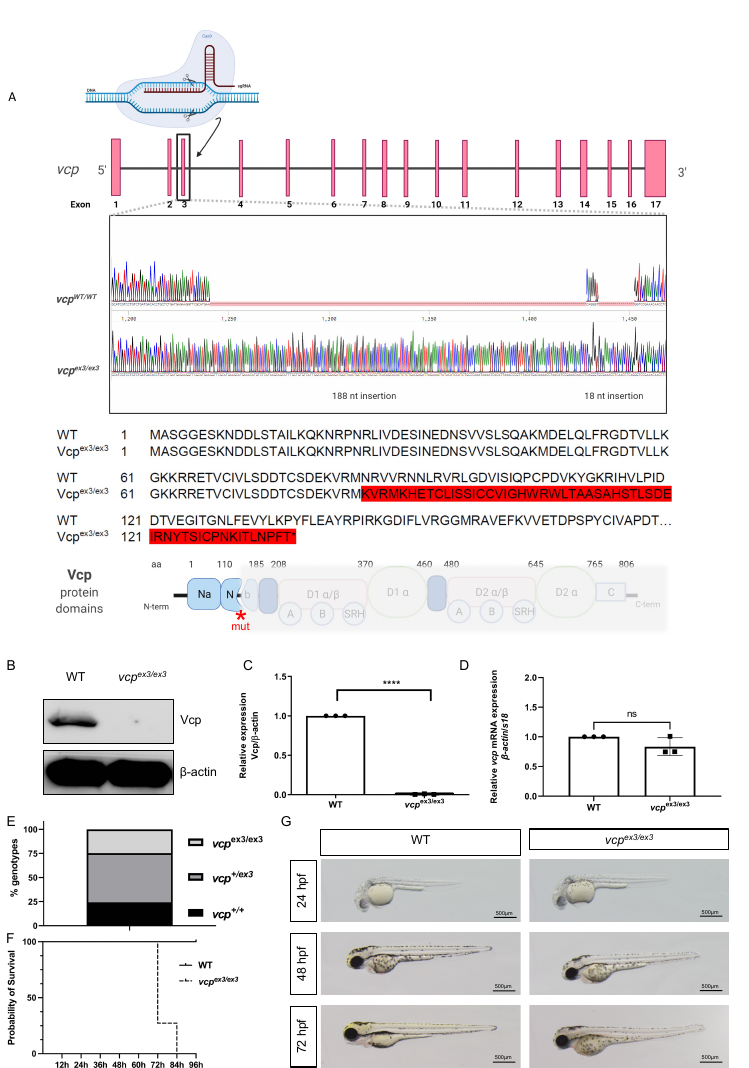
Figure 1. Generation of zebrafish vcp knockout by CRISPR/Cas9 gene editing. ( A ) Structure and partial sequence of the vcp gene and protein. CRISPR/Cas9 gene editing modifies exon 3 of vcp leading to the insertion of 206 nucleotides, a frame shift, and finally the introduction of a prema- ture stop codon, and thereby the premature termination of Vcp translation after 138 amino